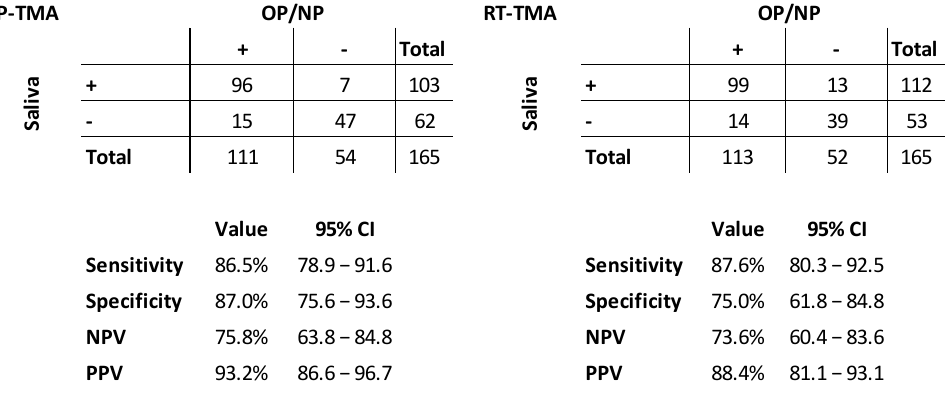
Figure 1. Test results and characteristics for EP-TMA (left) and RT-TMA (right) comparing saliva samples with OP/NP swabs ( n = 165). EP-TMA = End-Point Transcription-Mediated Amplification; RT-TMA = Real-Time Transcription-Mediated Amplification; CI = confidence interval; NPV = negative predictive value; PPV = positive predictive